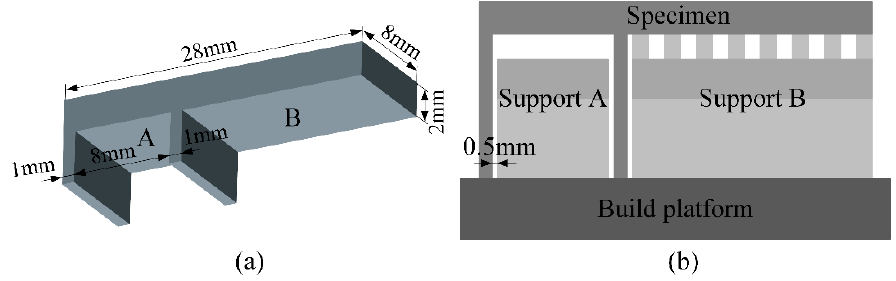
Figure 6. ( a ) 3D model of used specimens and ( b ) specimen with different supports.